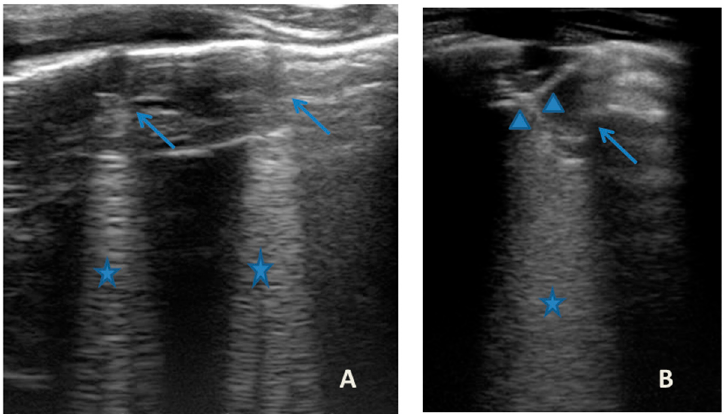
Figure 7. Grayscale lung ultrasound examination shows: ( A ): sub-centimeter consolidations less than 0.5 cm in size (arrows), associated with confluent artifacts (asterisks) in the left lateral mid-apical area; ( B ): a small consolidation of 0.5–1 cm (arrows), with elements of dynamic air bronchogram (arrowhead) (as per suspected inflammation) (10,15,16), associated with a circumscribed area of “white lung” (asterisks) in the right middle apical area; ( A , B ): irregularity of the pleural line. Picture compatible with acute inflammation of the small airways of viral origin (15,16).